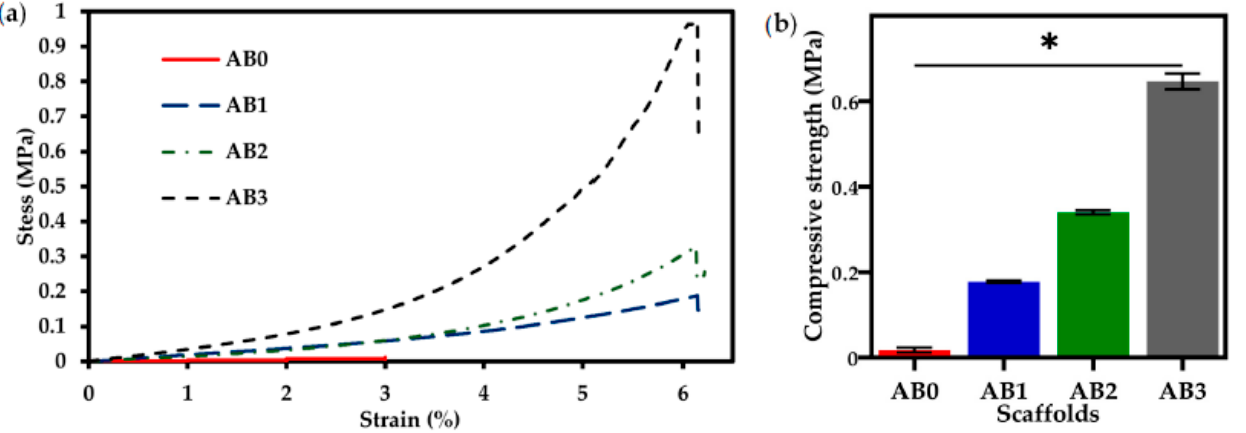
Figure 9. ( a ) Compressive stress vs. strain graph; and ( b ) compressive strength of the scaffolds (* p < 0.05; n = 3).